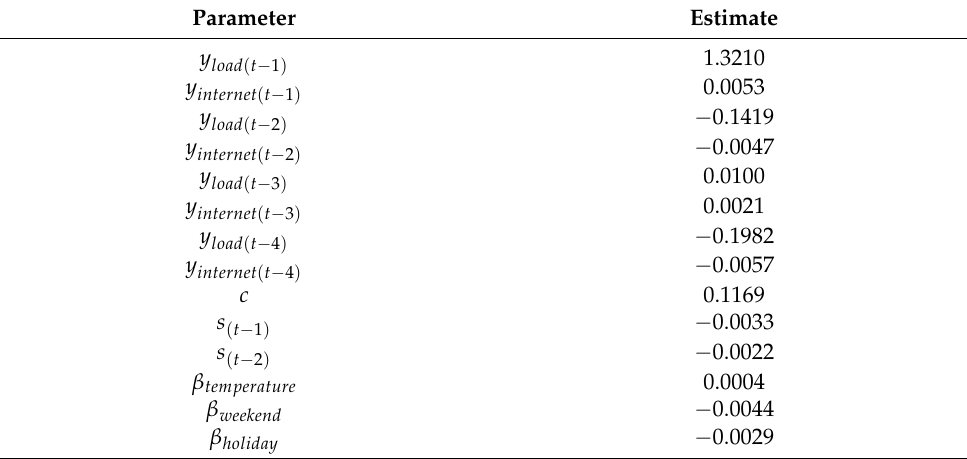
Table 6. Parameter estimations of VARX(4,0) model.